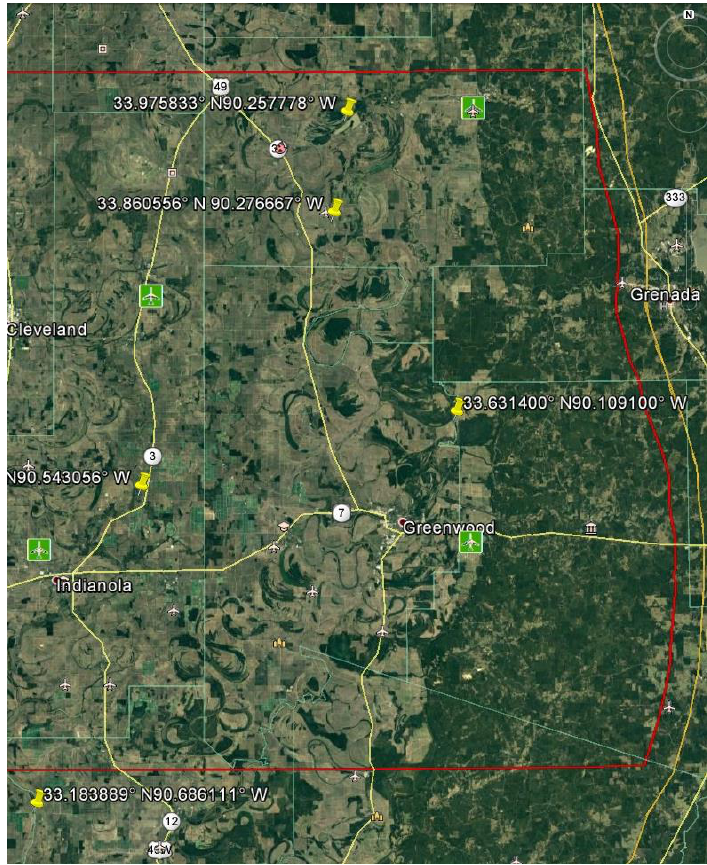
Figure 2. The areal extent of the Certificate of Authorization (CoA) for the data collection missions. The yellow pins indicate the positions of United States Geological Survey (USGS) river gauges, while the Greenwood-Leflore Airport is indicated by the aircraft icon east of Greenwood (near the center of the figure).